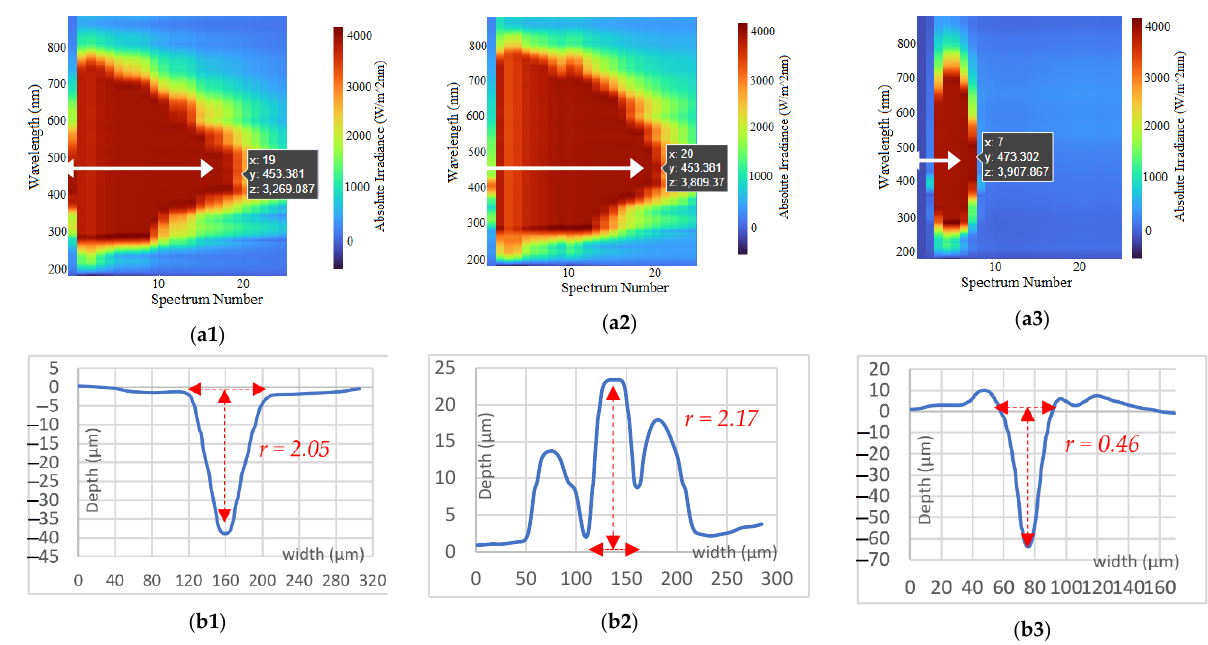
Figure 9. OES spectra of laser-aluminum interaction. ( a1 – a3 ): Heat map of OES; ( b1 – b3 ): profilometer data from 3D microscope; 1: Maximum Power; 2: Medium Power; and 3: Minimum Power of laser.